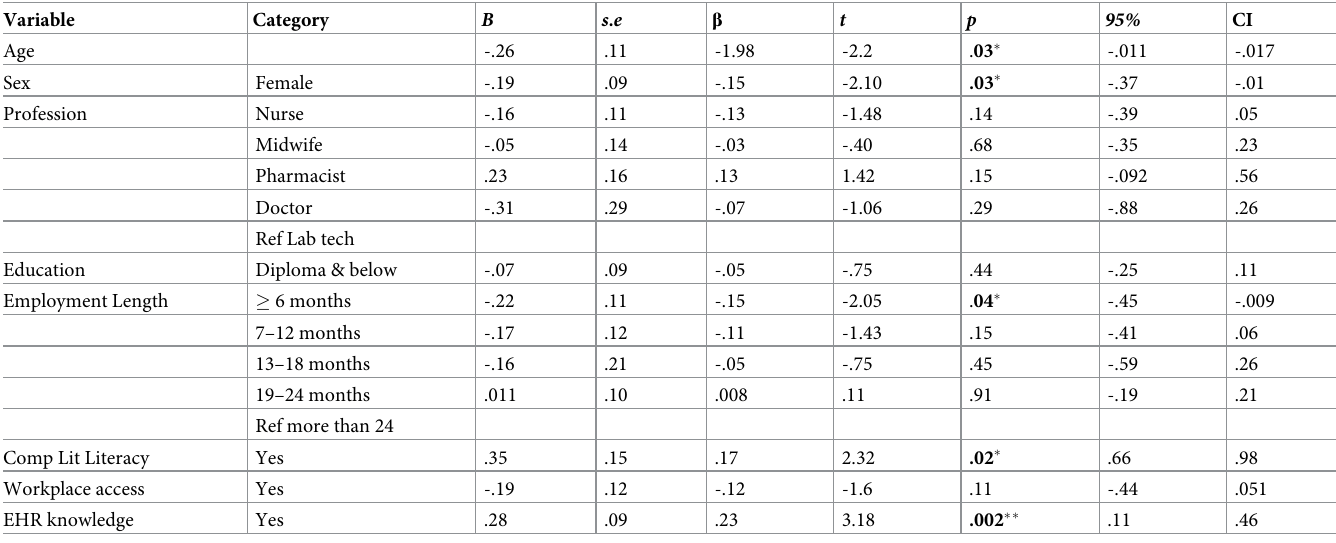
Table 4. Determinants of health provider readiness for